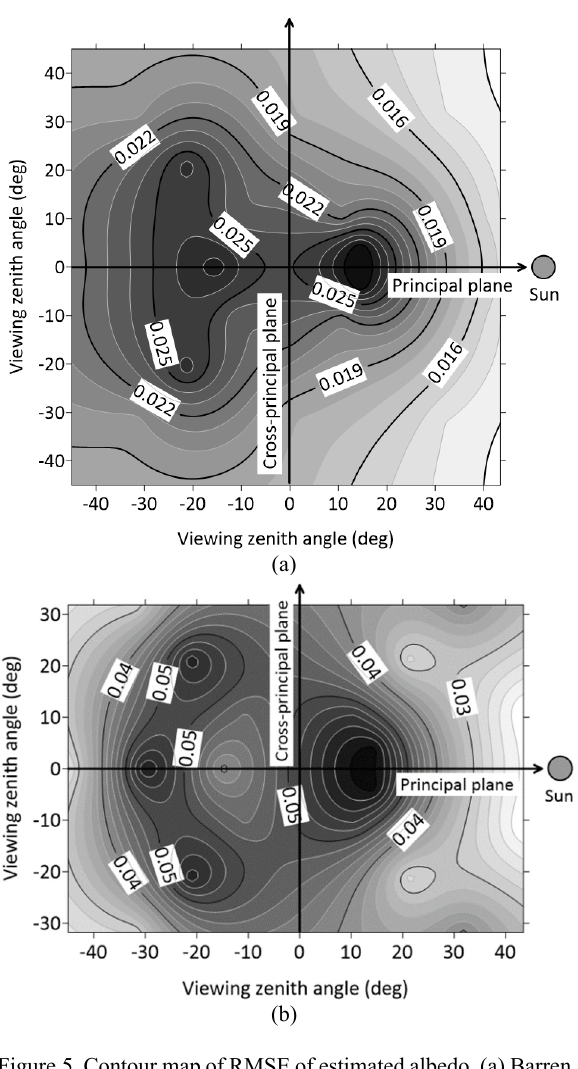
Figure 5. Contour map of RMSE of estimated albedo. (a) Barren or sparsely vegetated (IGBP LC16). (b) Deciduous broadleaf forest (IGBP LC4).